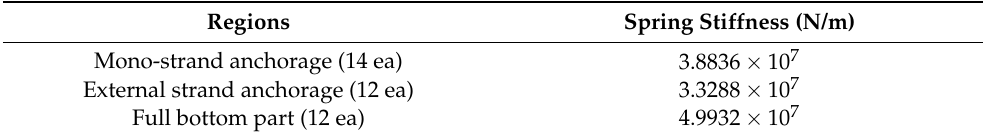
Table 4. Spring stiffness.